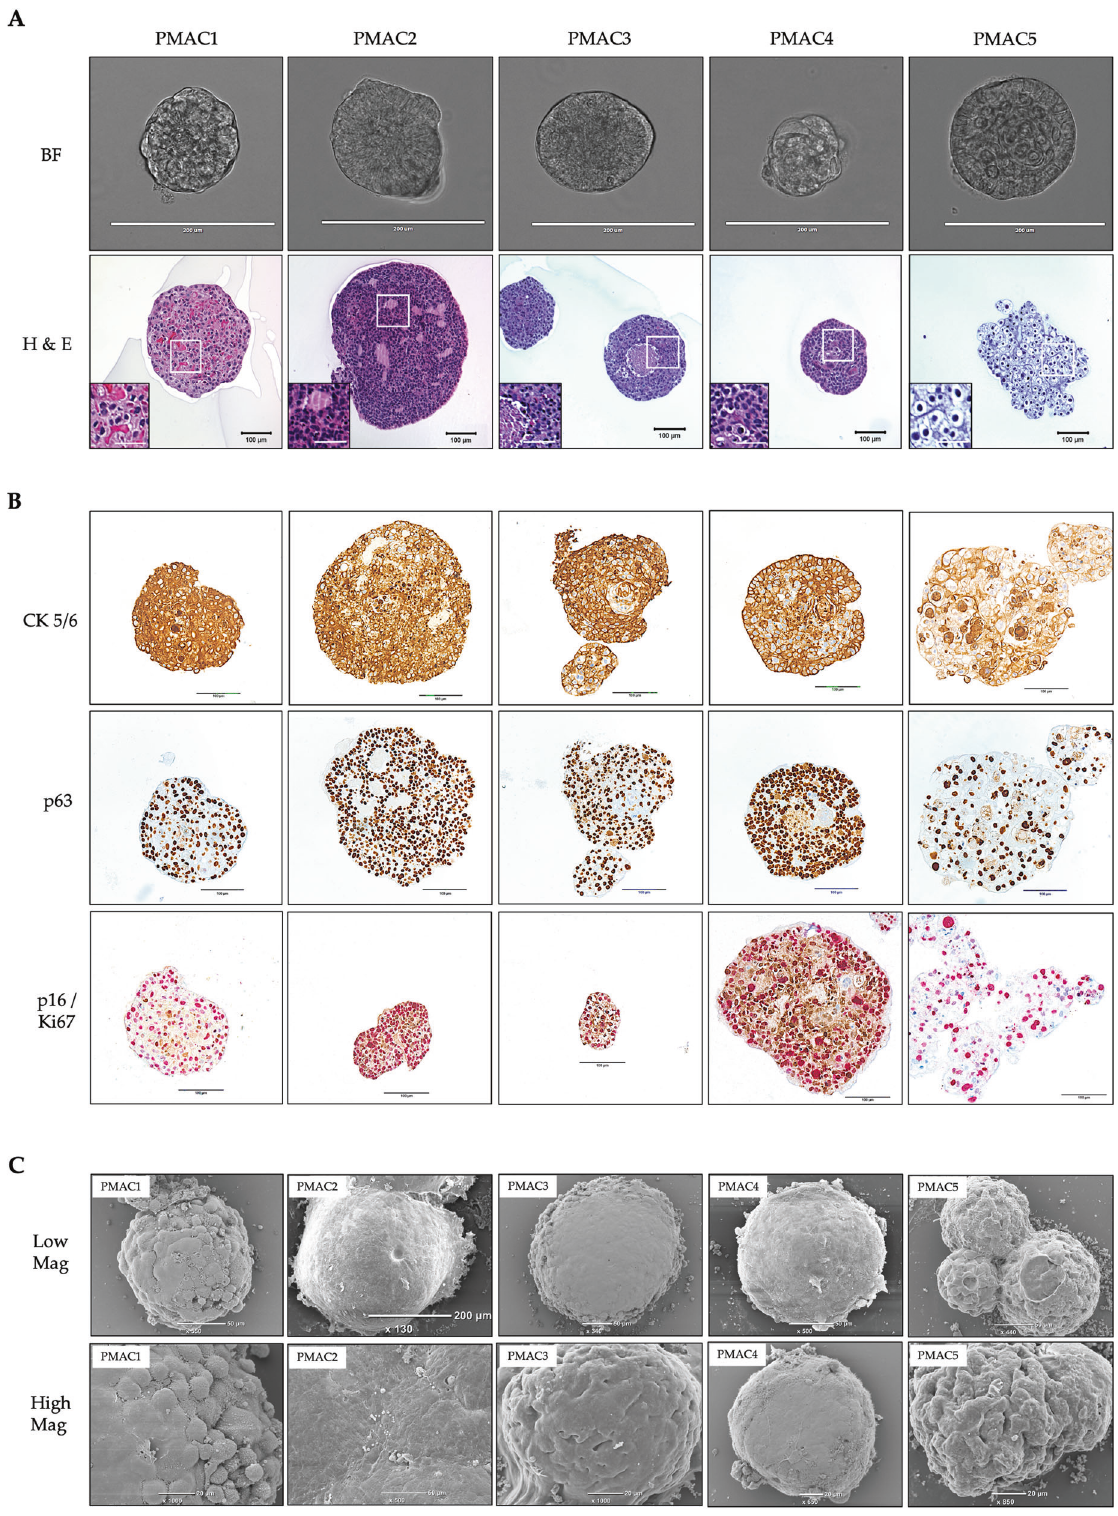
Fig. 2 Characterisation of anal SCC cell lines as 3D tumouroids. A Bright fi eld photomicrographs (scale bar 200 μ m) and haematoxylin and eosin staining (scale bar 100 μ m; inset 50 μ m) of cell line tumouroids 14 days following seeding of cells in Matrigel TM . B Tumouroids were fi xed with paraformaldehyde, embedded in histogel, sectioned and stained for CK5/6, p63 & p16 (brown chromagen)/Ki67 (red chromagen). C Surface architecture of cell line tumouroids assessed following growth for 14 days, retrieval, fi xation and processing for scanning electron microscopy (ScEM). (top row: low magni fi cation, scale bar 50 μ m except PMAC2 200 μ m; bottom row: high magni fi cation, scale bar 20 μ m, except PMAC2 50 μ m).